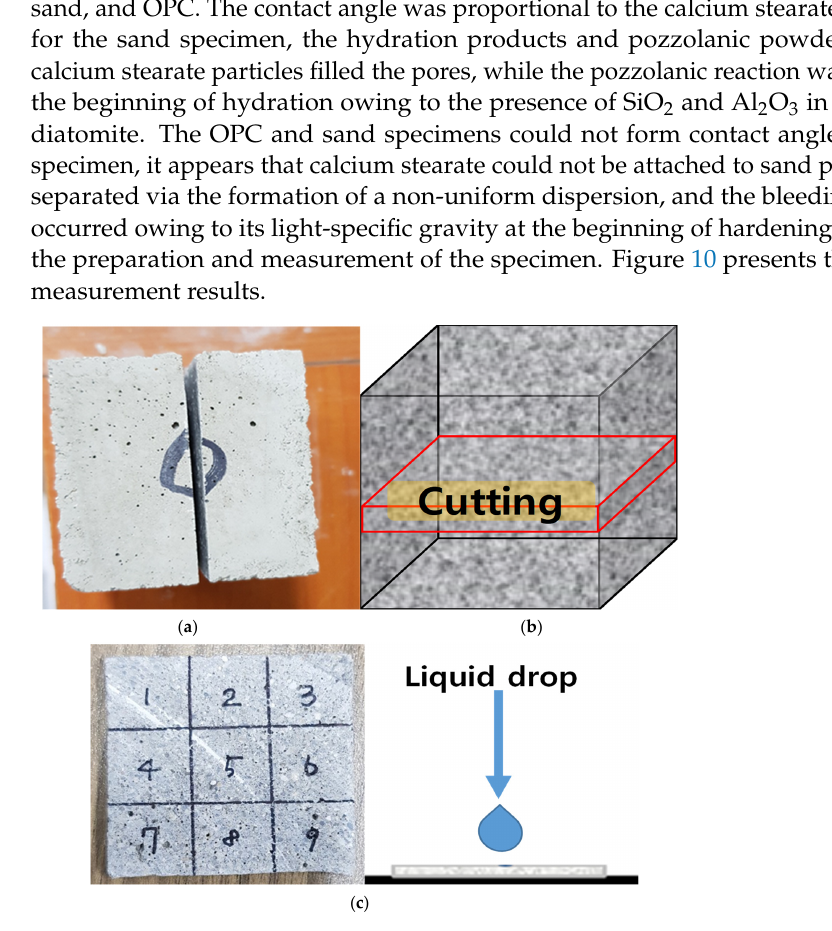
Figure 9. Specimen preparation and measurement. ( a ) Divided specimen; ( b ) end test specimen; ( c ) contact angle [46].